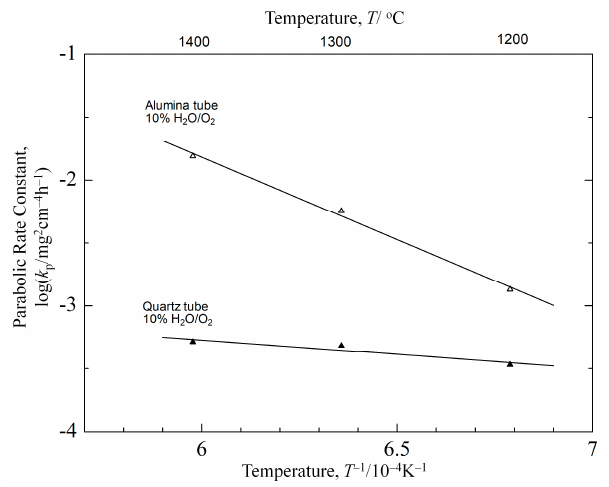
Figure 8. Effects of sodium and aluminum from the reaction tube (alumina tube) on parabolic oxi- dation rate of SiC in steam reported by Opila [51]. Due to the characteristics of the applications of SiC, most of the oxidation studies of SiC focused at temperatures ranging from 1000 to 1600 ° C. Although the normal cladding temperature of cladding is approximately 300 ° C, SiC ATF claddings may suffer temper- atures over 2000 ° C in the event of severe accidents [54]. It is necessary to verify the per- formance of SiC cladding, as well as other potential candidates for ATF claddings under severe accident conditions, above at least 1600 ° C in steam. However, the oxidation kinet- ics of SiC is still insufficient studied due to the lack of test facilities capable of operating in steam at temperatures above 1600 ° C. 3. Advanced Test Facilities for ATF-Claddings Steam oxidation tests at temperatures above 1600 ° C are very challenging as major refractory lining materials, such as alumina and even zirconia, in conventional test facili- ties are at their limits. In recent years, several efforts have been made to modify existing or to develop new test facilities [46,47] to study SiC under extreme conditions. To perform the oxidation tests at temperatures higher than 1600 ° C, the QUENCH-SR facility with utilization of induction heating was developed at Karlsruhe Institute of Technology [55]. First oxidation and quench tests of SiC at temperatures up to 2000 ° C in steam atmosphere were reported by Avincola et al. [46]. Under the same motivation, JAEA has also devel- oped a new test facility (Laser Heating Facility: LAHF) with utilization of laser heating for oxidation tests at extreme temperatures [47]. In this section, we introduce these two facil- ities. 3.1. Laser Heating Facility (LAHF) A schematic diagram of the laser heating facility is shown in Figure 9. This apparatus was designed for heat-treatment tests of small samples (less than 20 mm in diameter) in controlled environments (including vacuum) at temperatures beyond 1600 ° C. The main unit includes a laser head, vacuum pump, gas line heaters, flow rate controllers, and air- tight test vessel which is equipped with two radiation pyrometers, a W-Re 5-26 thermo- couple, and a video camera. Sample holders are made of zirconia. The laser light trans- mission, pyrometer temperature measurement, and in situ observation were made via five quartz windows (synthetic silica) located in the vessel wall. To avoid water vapor conden- sation, the test vessel, including gas pipes and quartz windows, are heated up to 200 ° C